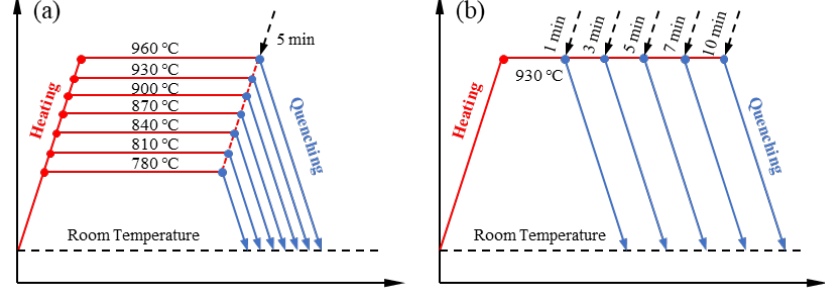
Figure 2. Quenching and heat treatment process: ( a ) different austenitizing temperatures; ( b ) different holding time.